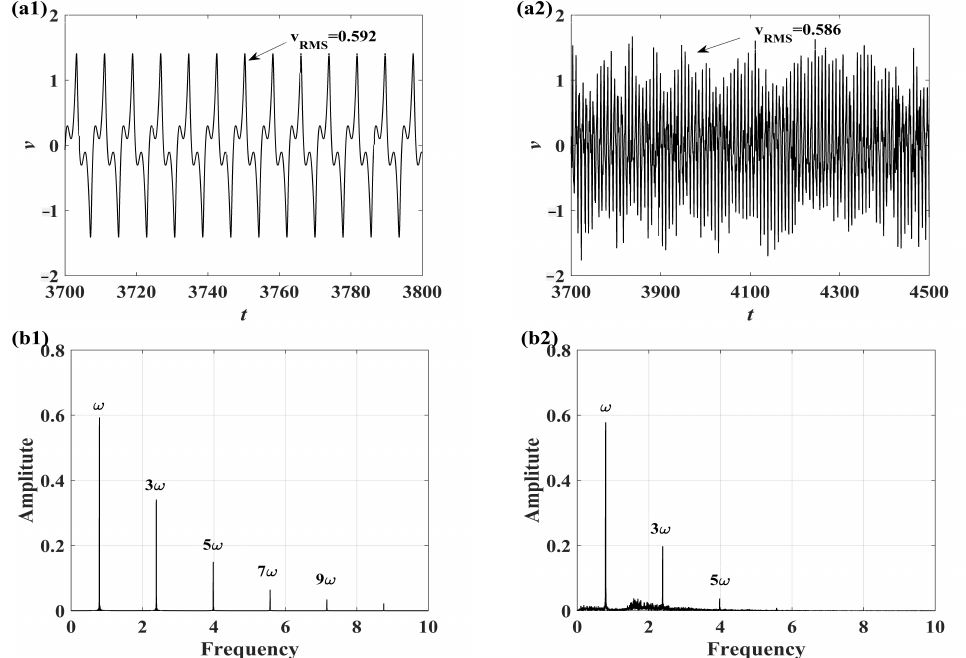
Figure 7. DR and EMR ( σ = 0.01) for ζ =0.01. ( a1 , a2 ) Time history of the output voltage of DR and EMR ( σ = 0.01); ( b1 , b2 ) Spectrum of the output voltage of DR and EMR ( σ =